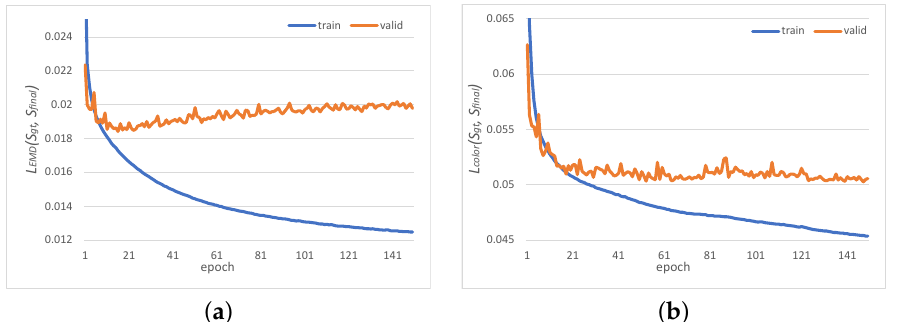
Figure 11. Losses during the learning. ( a ) EMD for final output; ( b ) CD-based color difference for final output.